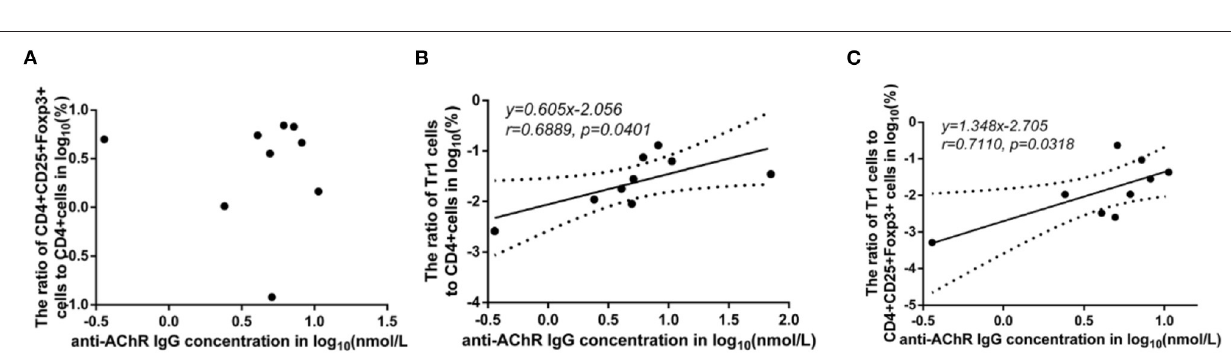
Frontiers in Neurology |